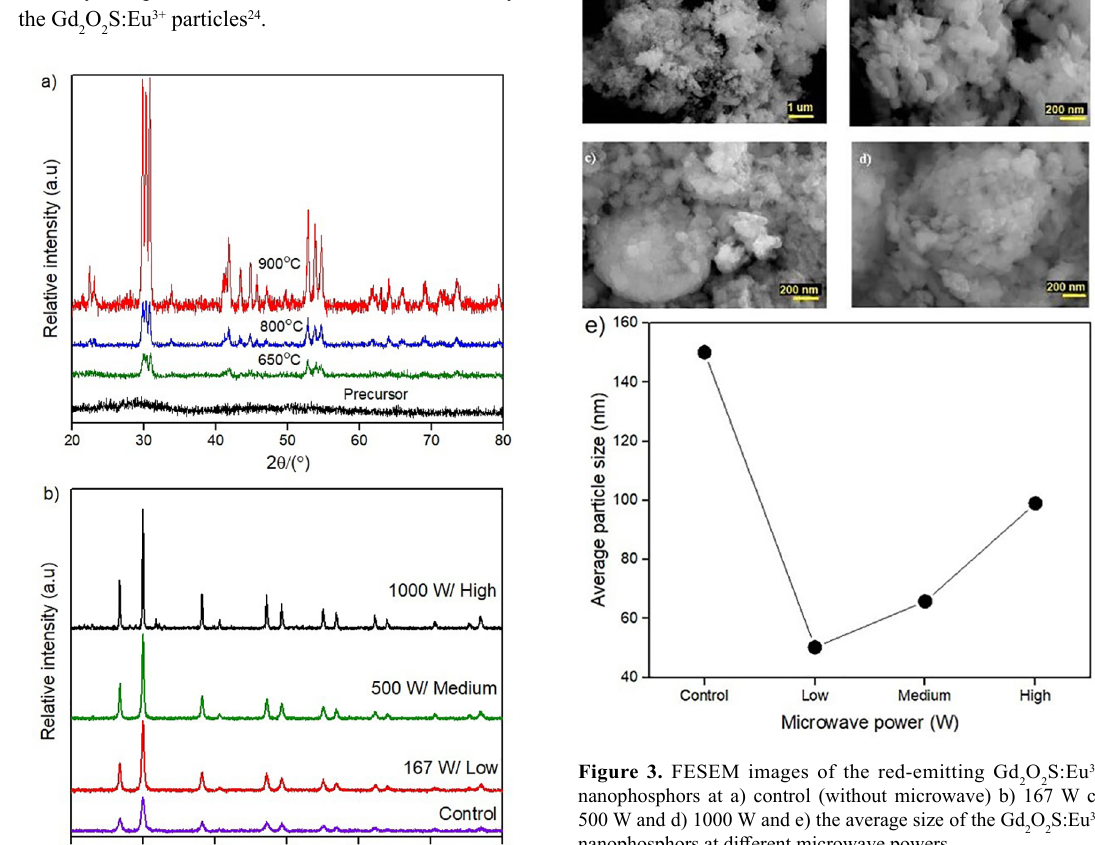
Figure 2. XRD patterns of a) the as-formed and calcined Gd nanophosphors (650, 800, and 900 °C without hydrogen flow at 1000 W) and b) Gd O S:Eu 3+ nanophosphors for control (without 2 2 microwave irradiation) and at low (167 W), medium (500 W), and high (1000 W) microwave irradiation powers.